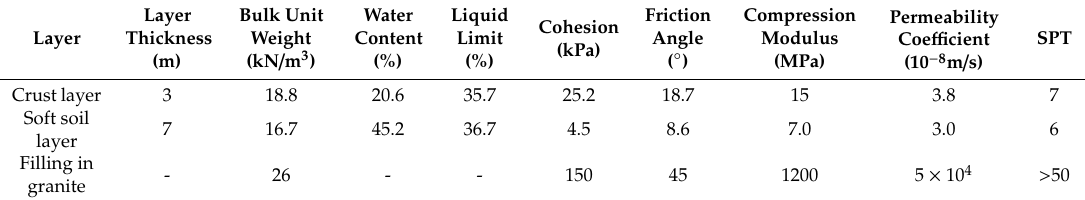
Figure 8. Schematic diagram of disposal of soft soil foundation by the replacement method. Table 4. Soil parameters of subgrade settlement monitoring section.